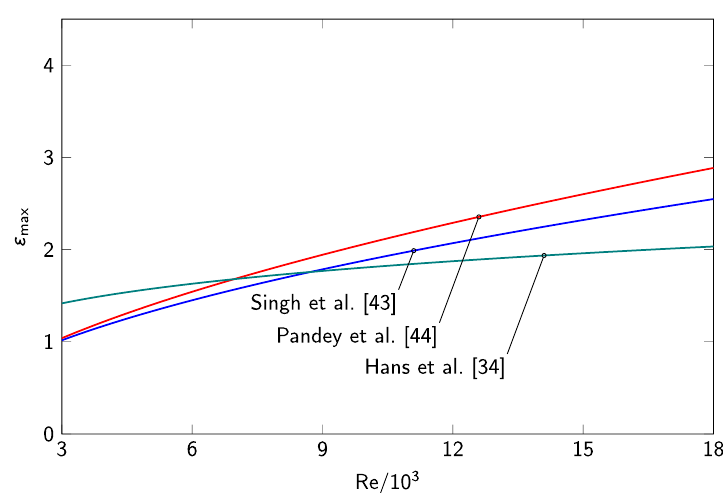
Figure 12. Relationship between ε max and Re for absorber plates with curved ribs.